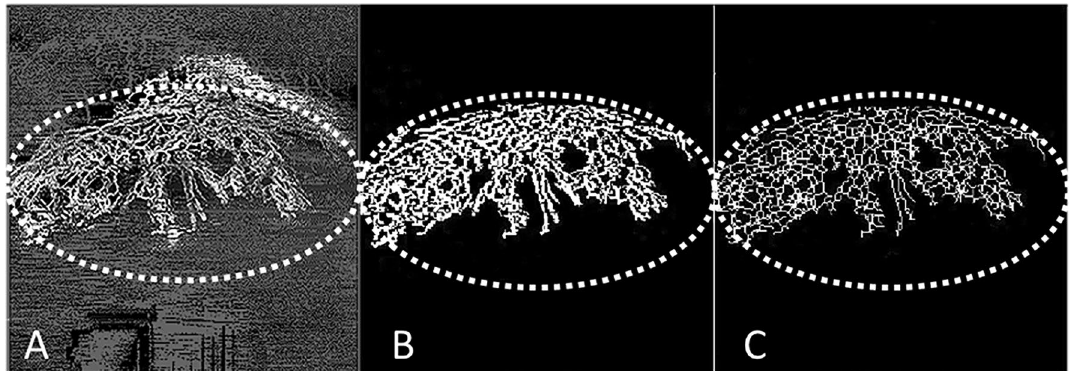
Figure 2. Image processing technique using an in-house automated programme written in MATLAB (Mathworks, Inc., Natick, MA, USA); the region of interest (ROI) is the area demarcated by the dotted line. ( A ) Example of corneal vascularisation captured using anterior segment optical coherence tomography (AS-OCT) angiography (Nidek RS-3000, Tokyo, Japan); ( B ) the overlay image is binarized at the ROI where white pixels represented the blood vessels and black represented the background—vessel density (VD) is the area of white pixels as a percentage of the whole binarized image; ( C ) Skeletonization of the binarized images, where all the vessel segments were reduced to one pixel-wide segment—vessel branch area (VBA) is the total length of the vessel branch as a percentage of the whole binarized image; the VD as a percentage of the VBA, represents the vessel width of the corneal vessels in the